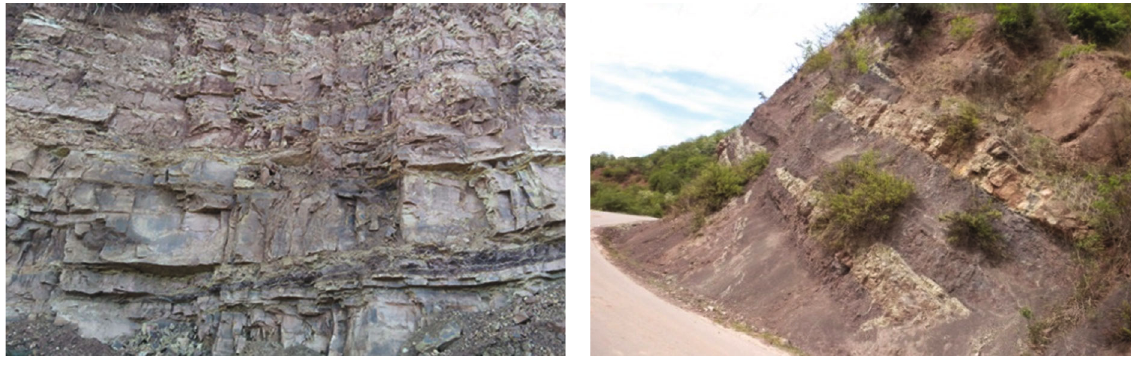
Figure 5: Interstrati fi cation type stratigraphic structure.